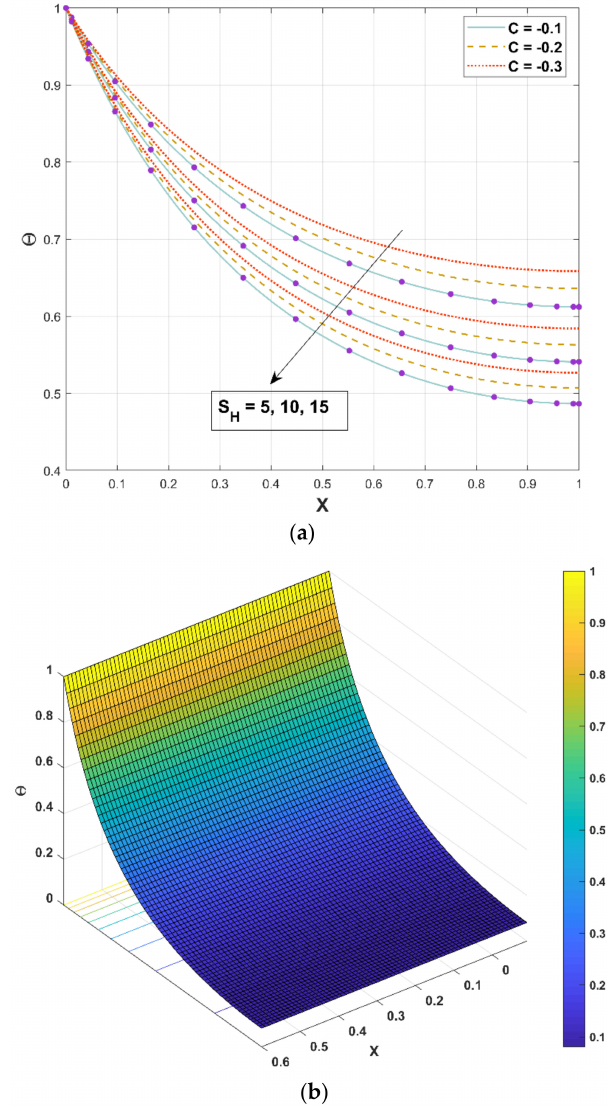
Figure 11. ( a , b ). Upshot of S H on Θ